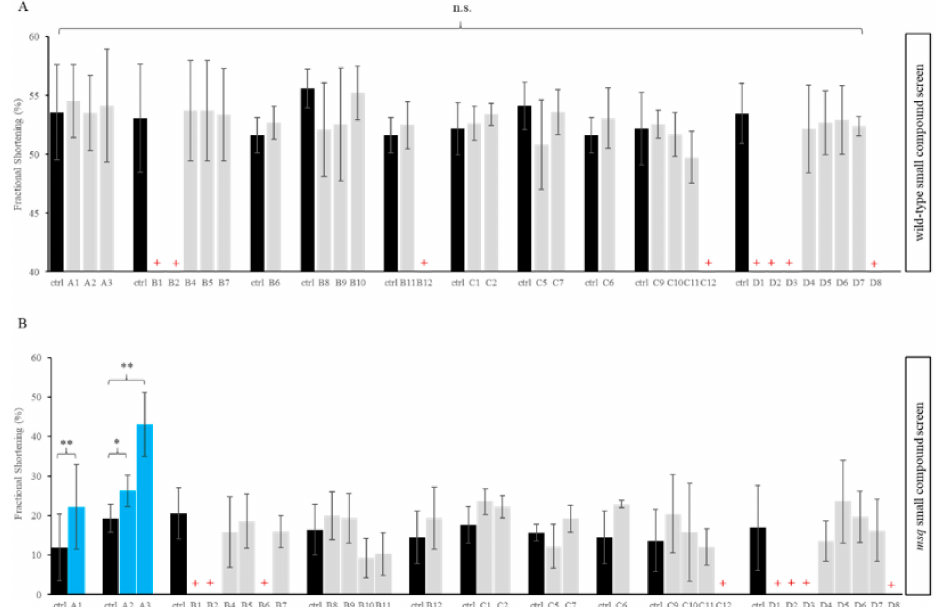
Figure 3. Primary small compound screen in msq mutants revealed three compounds to reconstitute fractional shortening (FS). Impact of tested compounds on ventricular fractional shortening in wild-type siblings as well as msq mutants. The data for average fractional shortening are plotted only for the compounds where at least three embryos could be quantified. ( A ) None of the embryos showed any increase or decrease in the average fractional shortening in wild-type embryos, whereas ( B ) compound A1, A2 and A3 results in significantly increased ventricular FS in msq mutants (*: Statistically significant, **: Highly significant, + : Lethal). For the drugs’ names, please refer to the Table A1 in the Appendix